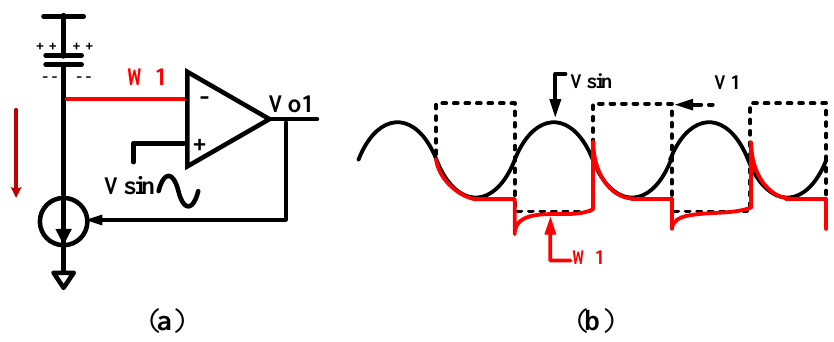
is low, the tracking 1